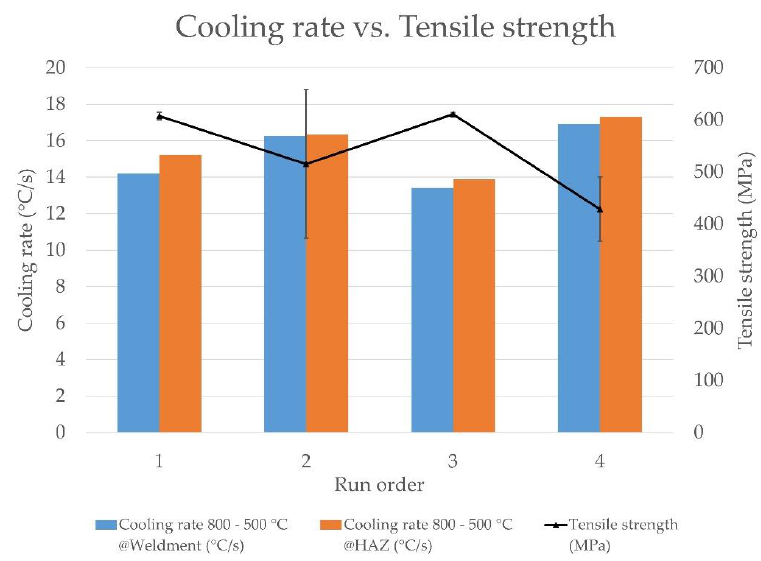
Figure 15. The relationship between cooling rate and tensile strength. For Vickers microhardness values measured at each specified position shown in Figure 16, the microhardness characteristics were shaped like a “W”, with all the smallest microhardness values at the HAZ area that was away from the welding center line about 5 mm, the measured microhardness was in the range of 180–210 HV, which was more than the standard microhardness of AISI 316 specified at 146 HV. It can be concluded that this parameter was suitable for use. The relationship